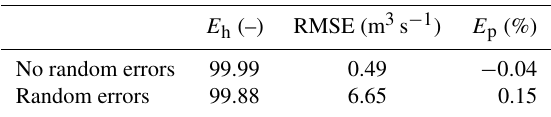
Table 2. Parma River: Nash–Sutcliffe E h , root-mean-square error (RMSE), and error in the peak discharge E p